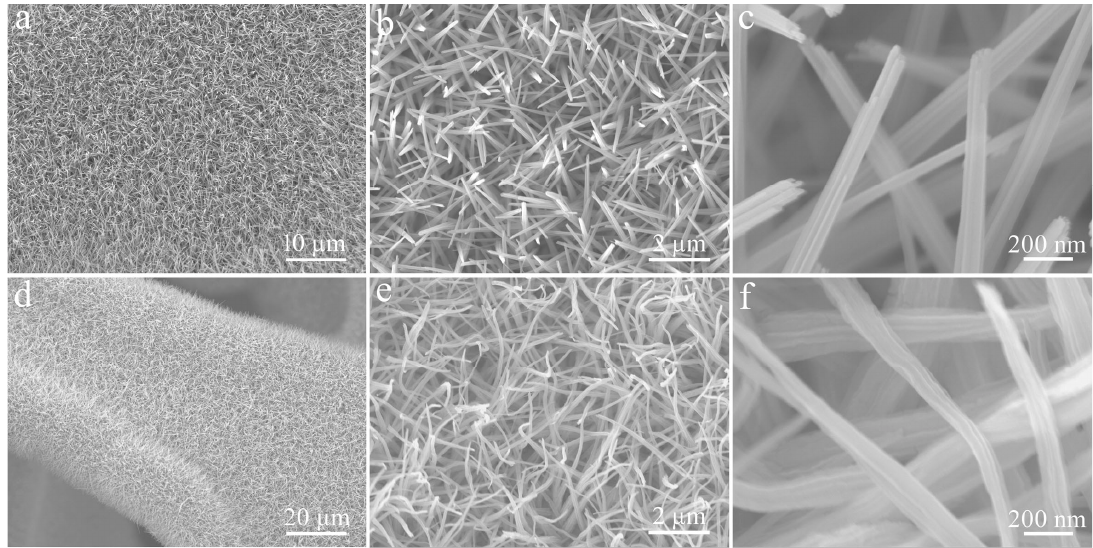
Figure 4. SEM images of ( a – c ) Cu(OH) 2 and ( d – f ) CuO. Figure 5 reveals the SEM images of CuO/NCS at di ff erent magni fi cations. As shown